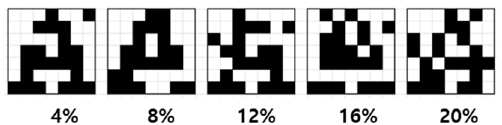
Figure 3. 7 × 7 inverted pixel “A” image with noise from 4% to 20%.